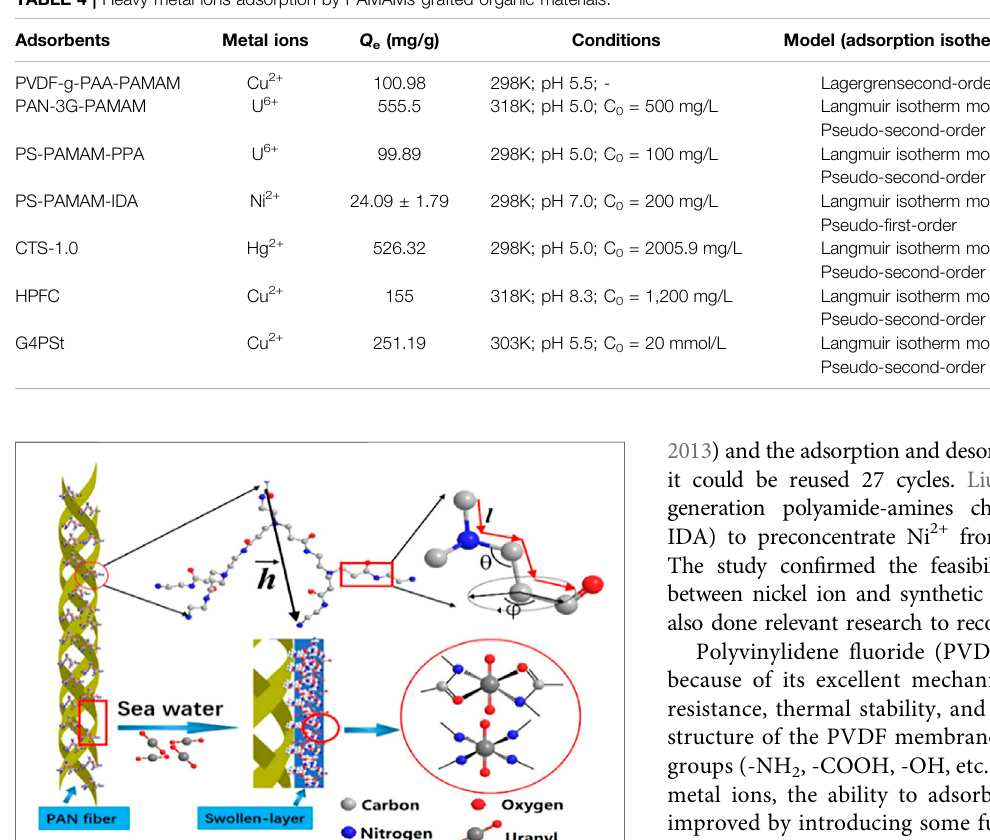
TABLE 4 | Heavy metal ions adsorption by PAMAMs grafted organic materials.